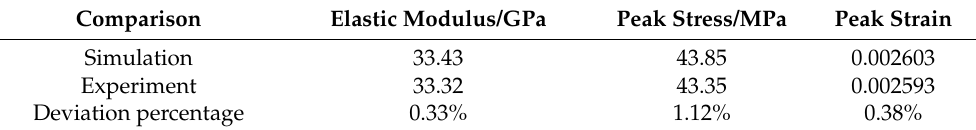
Table 5. Comparison of the simulation results and test results of C40 concrete uniaxial compression.